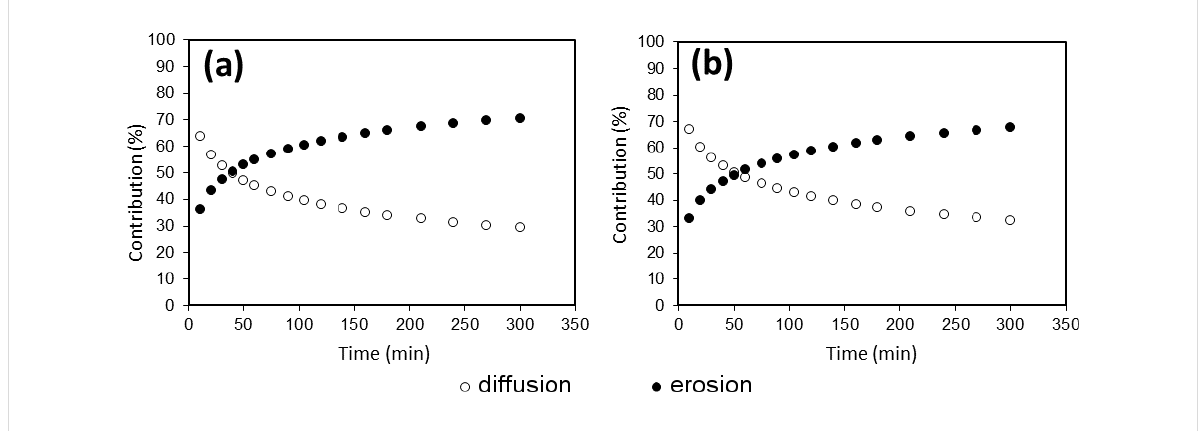
Figure 5: Contribution of diffusion (open circles) and erosion (filled circles) mechanisms from polymers a) T25a10 and b) T15a10 regarding the delivery of lactase.